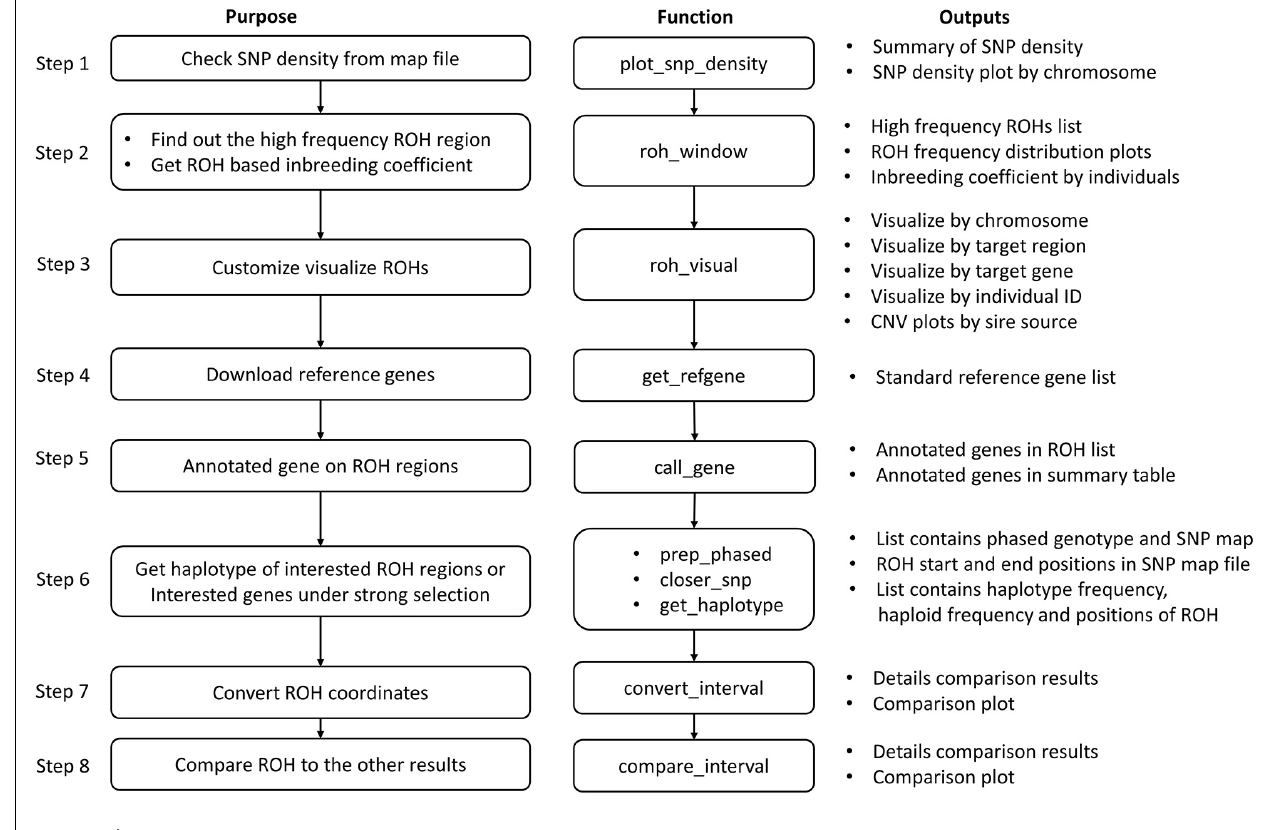
FIGURE 3 | Pipeline of post-analysis of ROH in